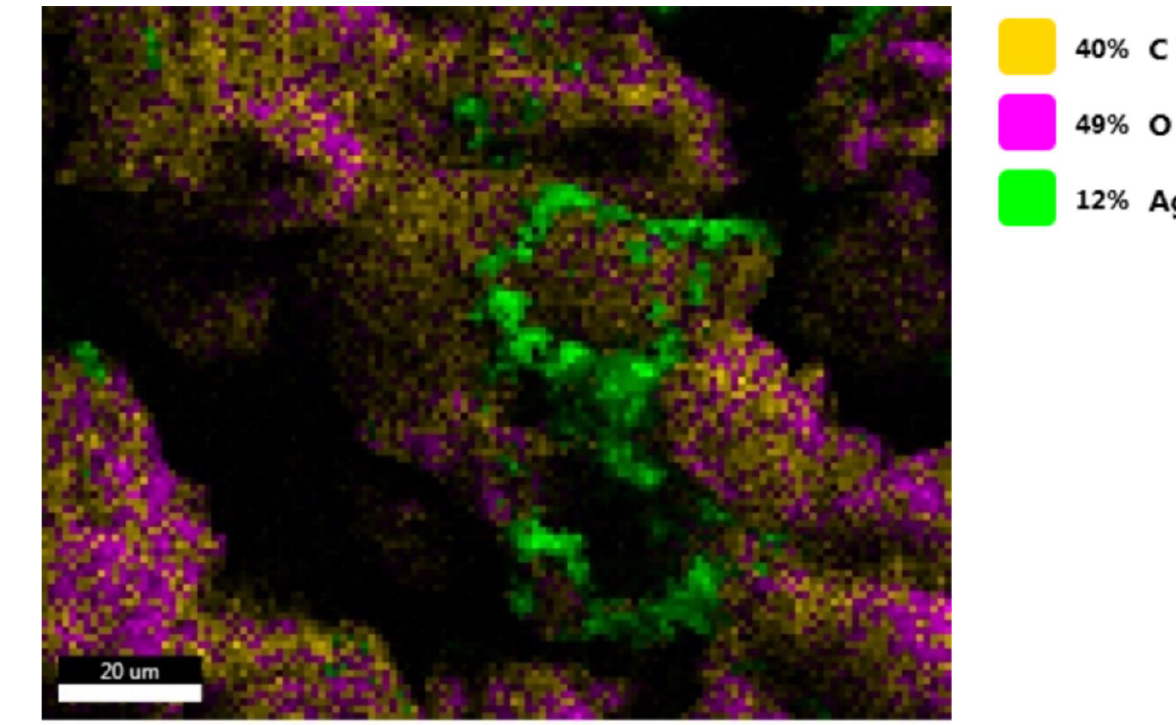
Figure 16. SEM live map of the new phytocarrier system.